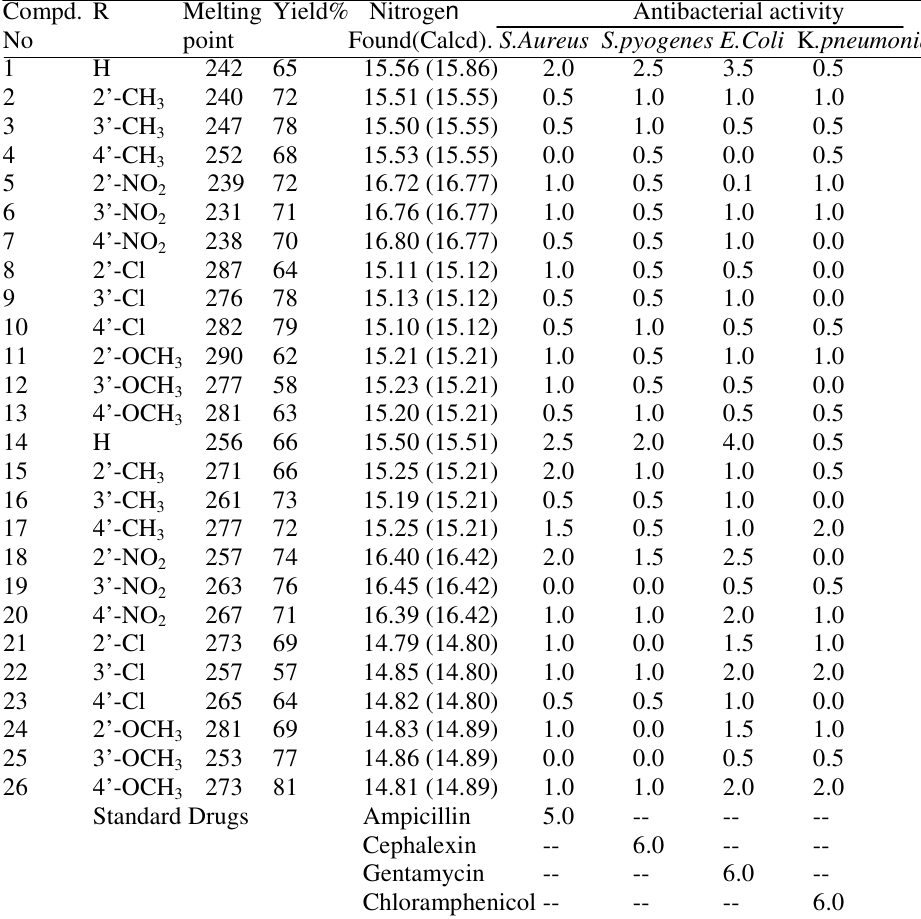
Table 1. Analytical and antimicrobial activity data of the compounds 1 – 26. Compd.